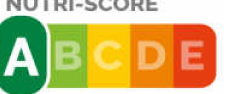
Figure 1. Nutri-Score logo.